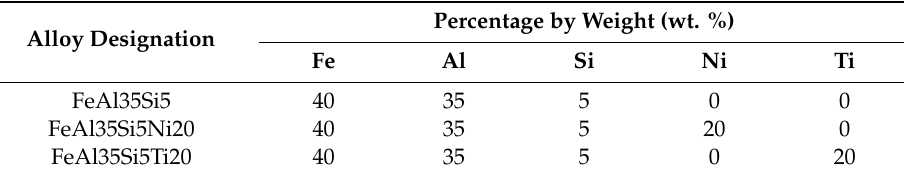
Table 1. Nominal chemical composition of the tested